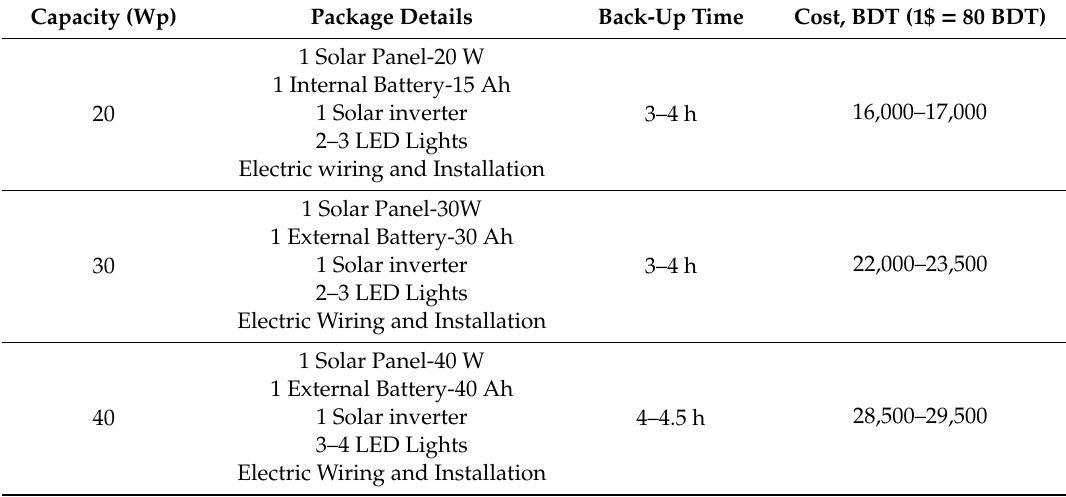
Table 3. The average package details and cost of stand-alone solar home systems (SHS) in the study area. Capacity